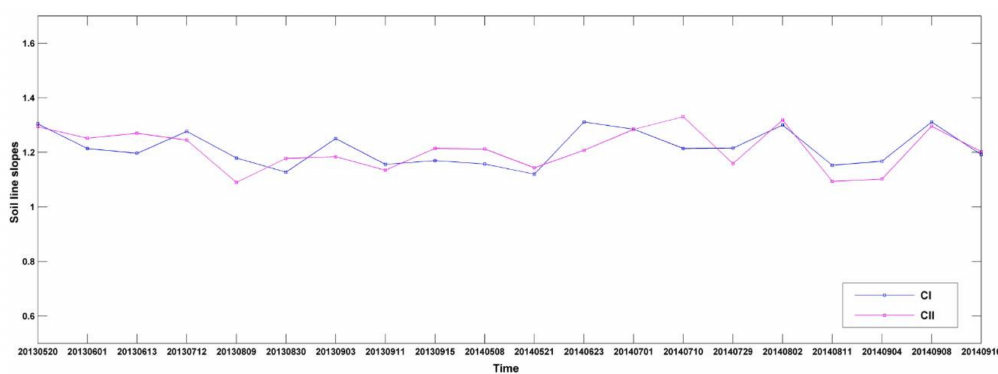
Figure 3. Soil line slopes for soil type of CI,